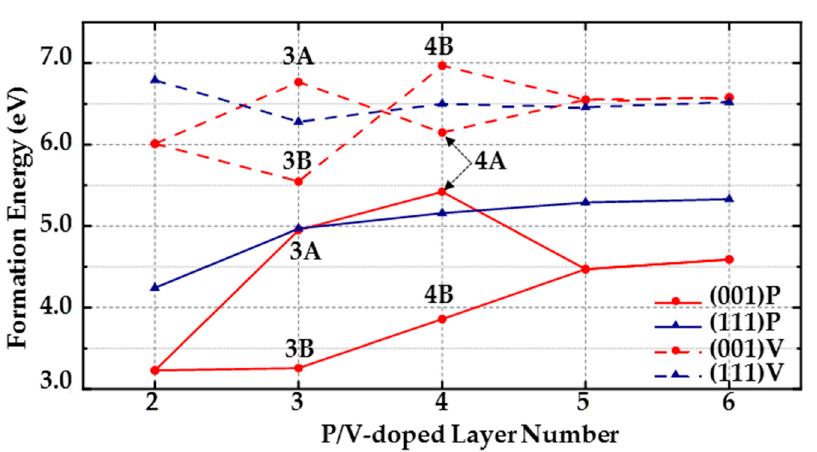
Figure 2. Formation energies of the single V and single P atom doped in (001) and (111) surfaces. (The doped positions are illustrated in Figure 1).